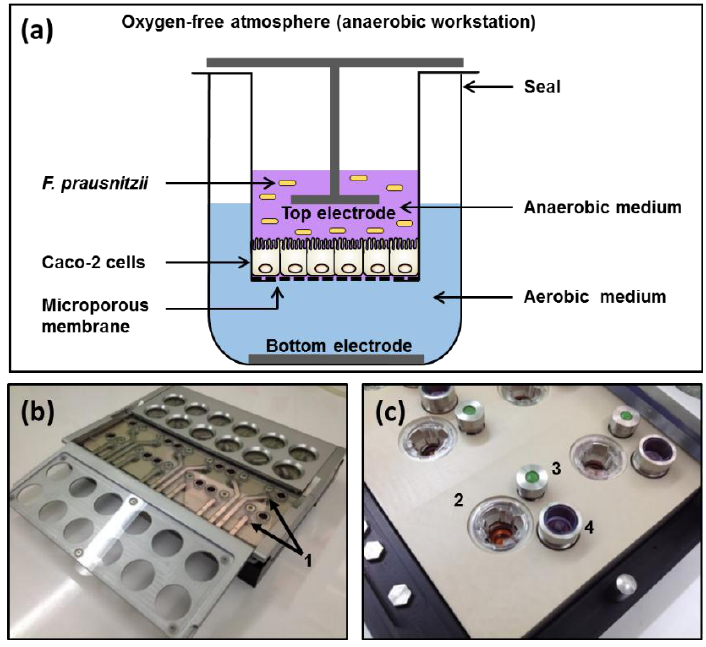
Figure 1. Apical anaerobic co-culture model. ( a ) Schematic diagram of a single well of the apical anaerobic co-culture model used for the co-culture of Caco-2 cell monolayers with anaerobic F. prausnitzii. The top and bottom electrodes enable the determination of the effect of F. prausnitzii on TEER across the Caco-2 cell monolayers; ( b , c ) Photographs of the co-culture chamber including details of the components. 1: Top electrodes; 2: Transwell insert containing Caco-2 cell monolayer; 3: Septum for basal media sampling; 4: One-way pressure relief valve.